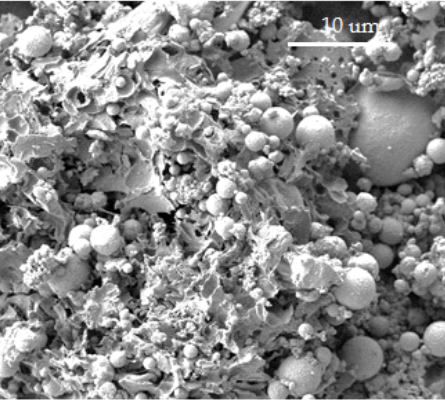
Figure 1. SEM image of the genuine fly ash.